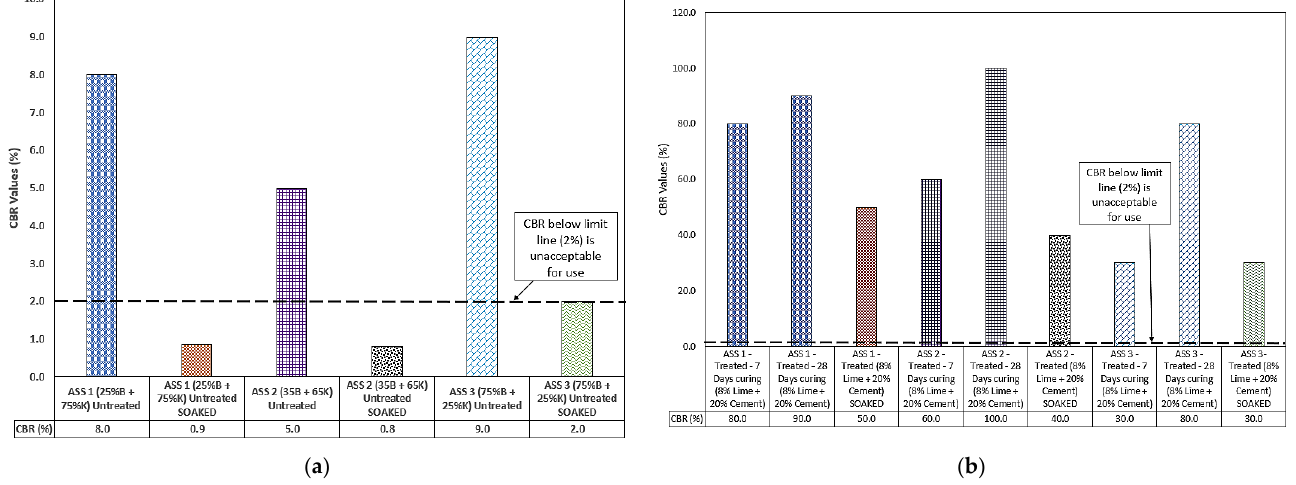
Figure 10. ( a ) Results for the untreated ASS materials, where B is bentonite and K is kaolinite; ( b ) treated artificially-synthesized subgrade.